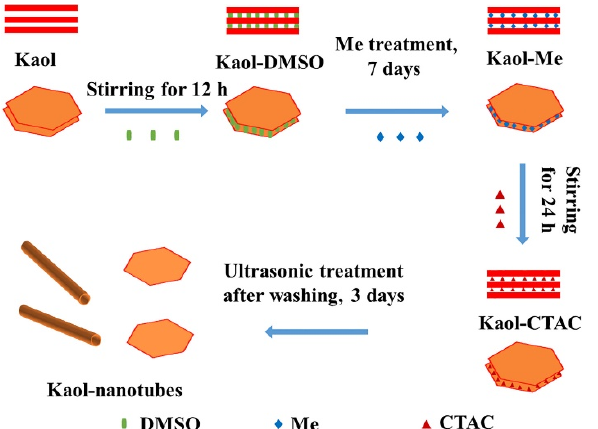
27 of 39 Figure 17. Form-stable PCMs: microencapsulated PCM bound to the surface of textile fibres ( left ); integrated into textile fibres ( middle ); plate-shaped composite material with embedded PCM ( right ), Mehling et al. [148]. Reproduced with permission from Elsevier. The PCMs currently used in form-stable combinations are paraffins, fatty acids and their blends, polyethylene glycol, Kenisarin and Kenisarina [103]. Form-stable PCMs have several advantages over encapsulated PCMs: better dynamics of the charging/discharging process, better chemical and physical stability, higher heat transfer area-to-volume ratio. There is much more flexibility and variety in the choice of materials. The list of matrix materials mentioned in Figure 2 only includes the main ones but new materials are added continuously as the research in the field progresses. A recent review article Gao [149] identified five types of PCMs integration mecha- nisms into a matrix material: (1) layered packaging, (2) tubular packaging, (3) porous packaging, (4) core–shell packaging and (5) network packaging. A. Layered-packaging/Tubular packaging. Zhang et al. [82] designed a process repre- sented schematically in Figure 18 to prepare (Kaol)–cetyl trimethylammonium chlo- ride intercalation compound (Kaol-nanotubes) through the intercalation method and ultrasonic treatment. This material was used to prepare a SA/Kaol-nanotube compo-